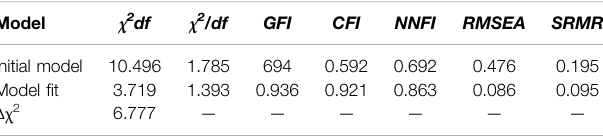
TABLE 1 | Fit indices for arti fi cial intelligence, facilitating adoption, sustainability, ESG investment, intelligent automation tourism, and internet of things among tourists ( N = 402).